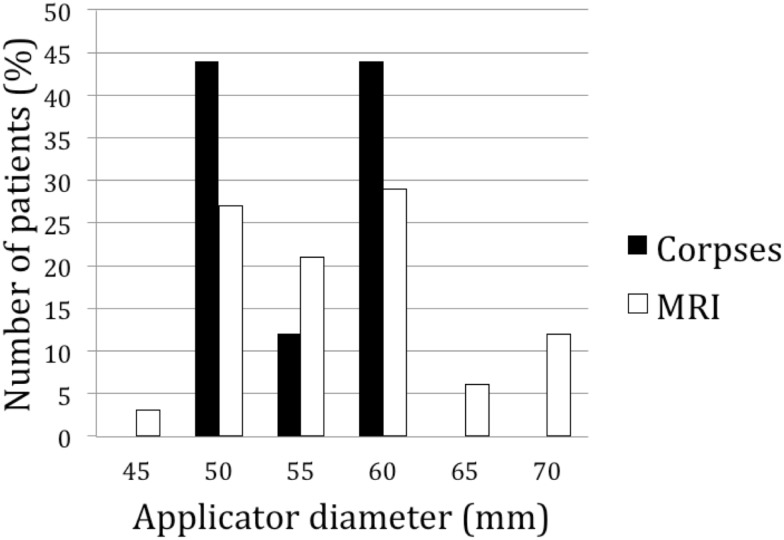
Distribution of the diameter of the applicator among 9 prostatectomized cadavers (plain bars), and in MRI images from 34 prostate cancer patients (empty bars).